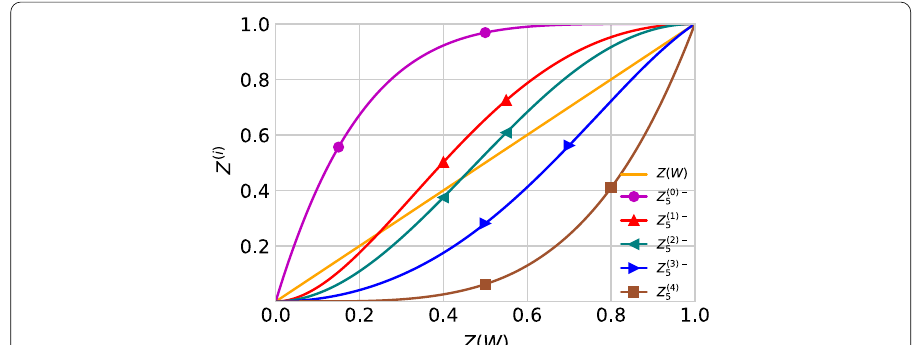
Fig. 3 The upper Bhattacharyya parameter bounds of G 5 : Z ( W ) denotes the Bhattacharyya parameter of the transmission channel